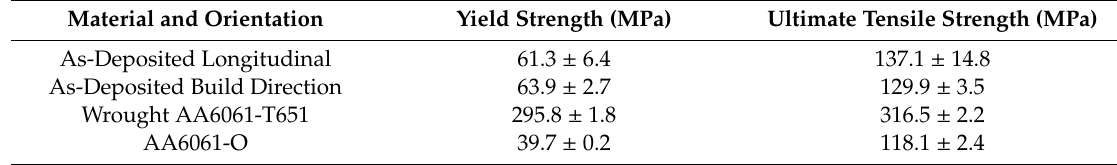
Figure 4. Monotonic engineering stress–strain curve of wrought AA6061-T651, AFS-D AA6061 as-deposited longitudinal direction, AFS-D AA6061 as-deposited build direction, and the annealed wrought AA6061-O. Table 2. Monotonic strength properties for feedstock and as-deposited AFS-D material.